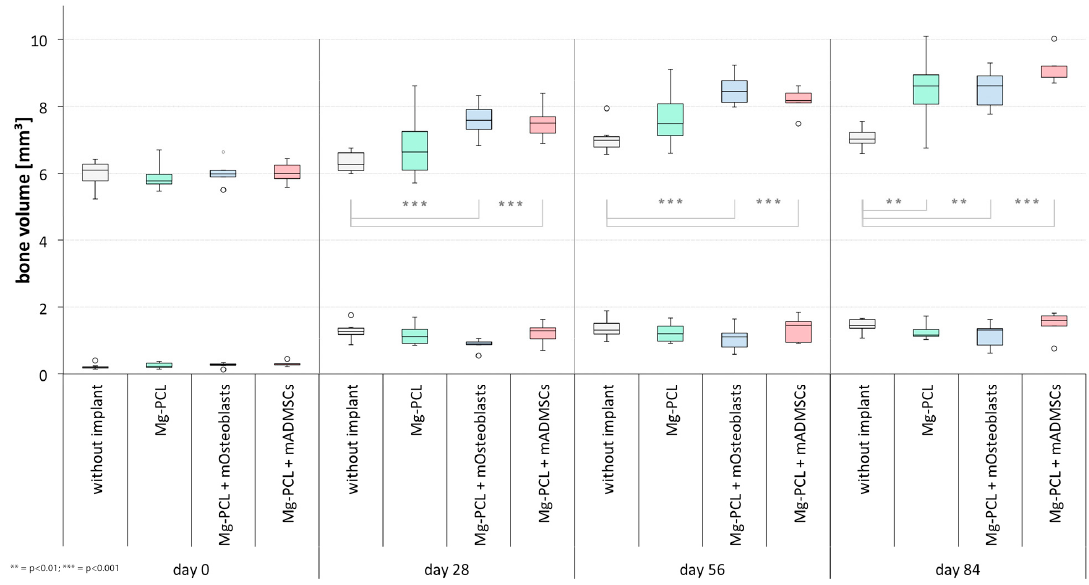
28 (Figure 8, lower row; without implant: p < 0.0001; Mg-PCL: p = 0.0003; Mg-PCL + mOsteoblasts: p < 0.0001; Mg-PCL + mADMSCs: p = 0.0033). Neither between the subsequent measurement days for each experimental group (Figure 8, lower row) nor between the groups at each measured time (Figure 7, lower row) could significant differences in bone volume formation be detected.